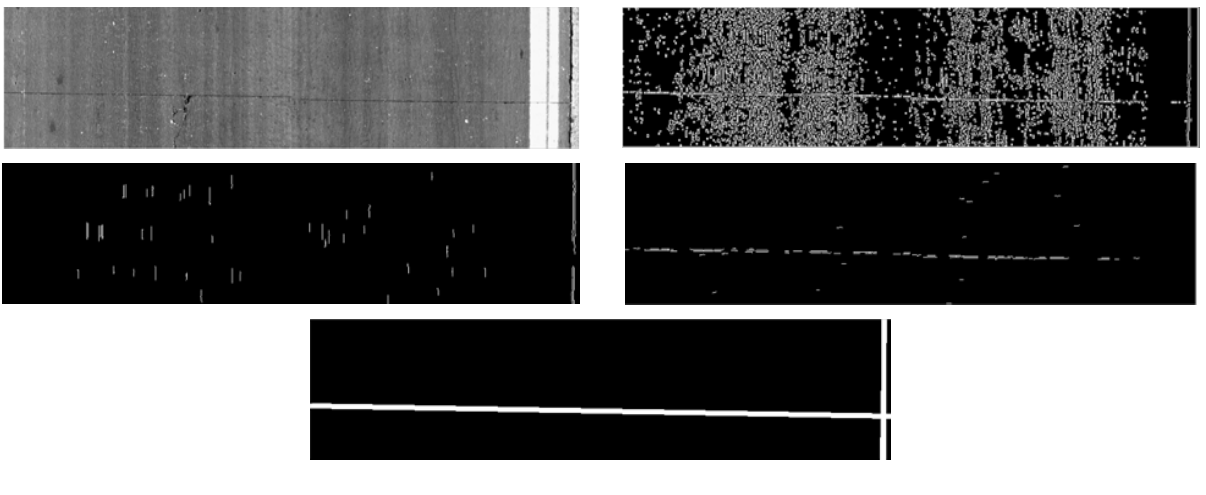
Figure 7. From upper row to lower row: downsized original image, Canny image, image with vertical segments, image with horizontal segments, Hough transform